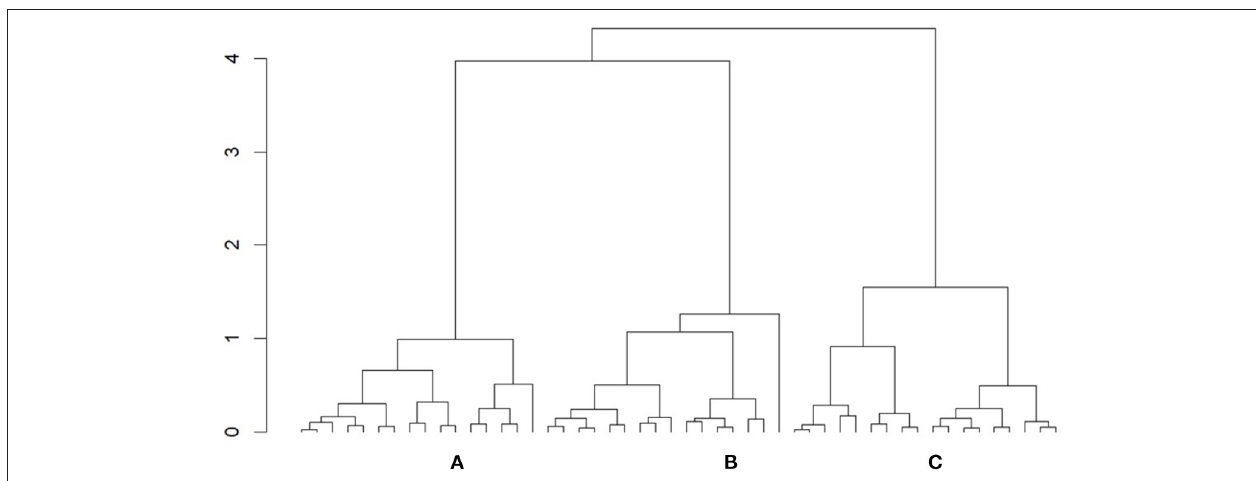
FIGURE 7 | Dendrogram of the cluster analysis with the three cluster (A–C)